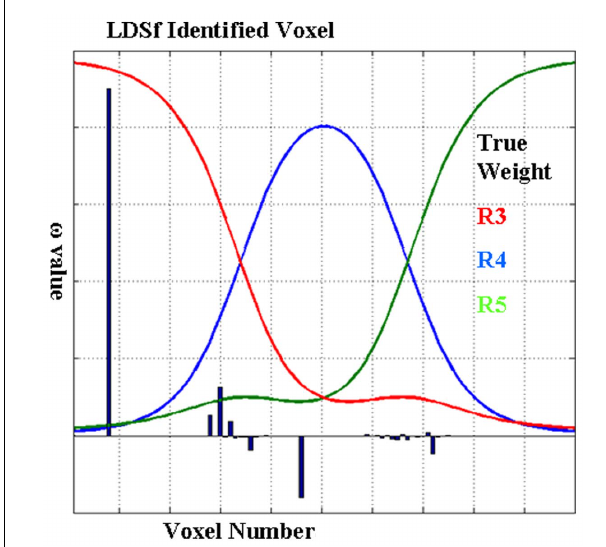
FIGURE 6 | Results from the CCA-LDSf model. CCA-LDSf was used to identify a small number of “best” voxels from the 100 voxels in region 3 that interacted with regions 1 and 2 (see Figure 5 ). Signal three contains the optimal signal.Voxels with high weights on signal three (red weights) should be selected while voxels with low weights on signal three should be avoided.Values of weights for each voxel as estimated by the CCA-LDSf model are shown in bars. A voxel with near maximal true weight on signal 3 was chosen as the optimal voxel by the